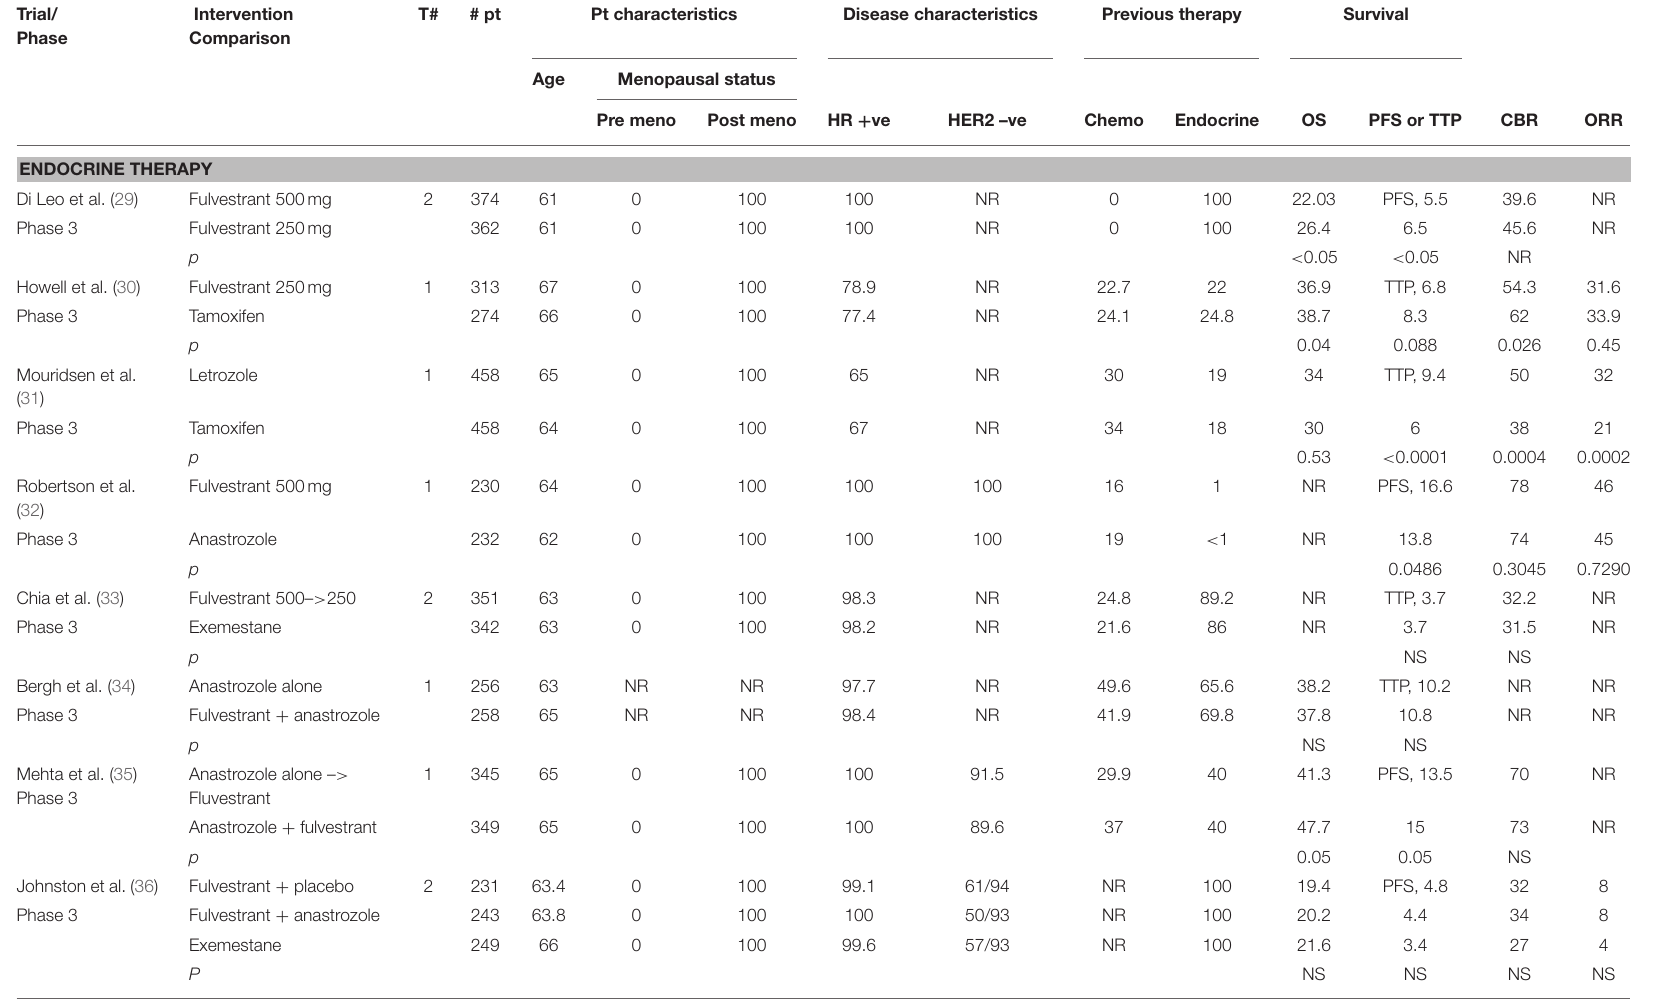
TABLE 1 | Endocrine therapy in